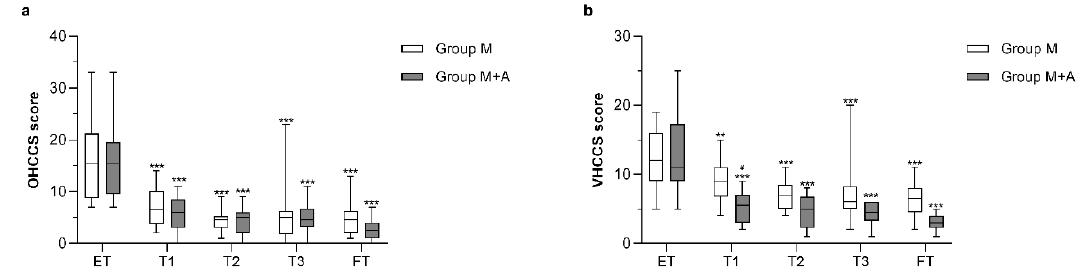
Figure 4. Owner’s hyperthyroid cat clinical score (OHCCS) ( a ) and veterinarian’s hyperthyroid cat clinical score (VHCCS) scores ( b ) in hyperthyroid cats receiving methimazole and placebo (group M, n = 14), or methimazole and antioxidants (group M + A, n = 16). Asterisks indicate statistically significant di ff erences compared to ET (** p < 0.01 and *** p < 0.001). Hashtags indicate statistically significant di ff erences compared to group M (# p < 0.05). Statistical analysis was performed by two-way ANOVA for repeated measures followed by Sidak’s post-hoc test. ET = enrollment time; T1 = 15 days; T2 = 30 days; T3 = 90 days; FT = finish time (180 days).